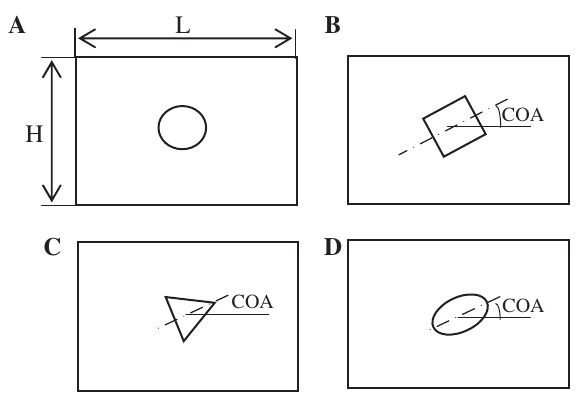
Figure 2 Cutouts used in the analyses: (A) circular, (B) square, (C) triangular and (D)